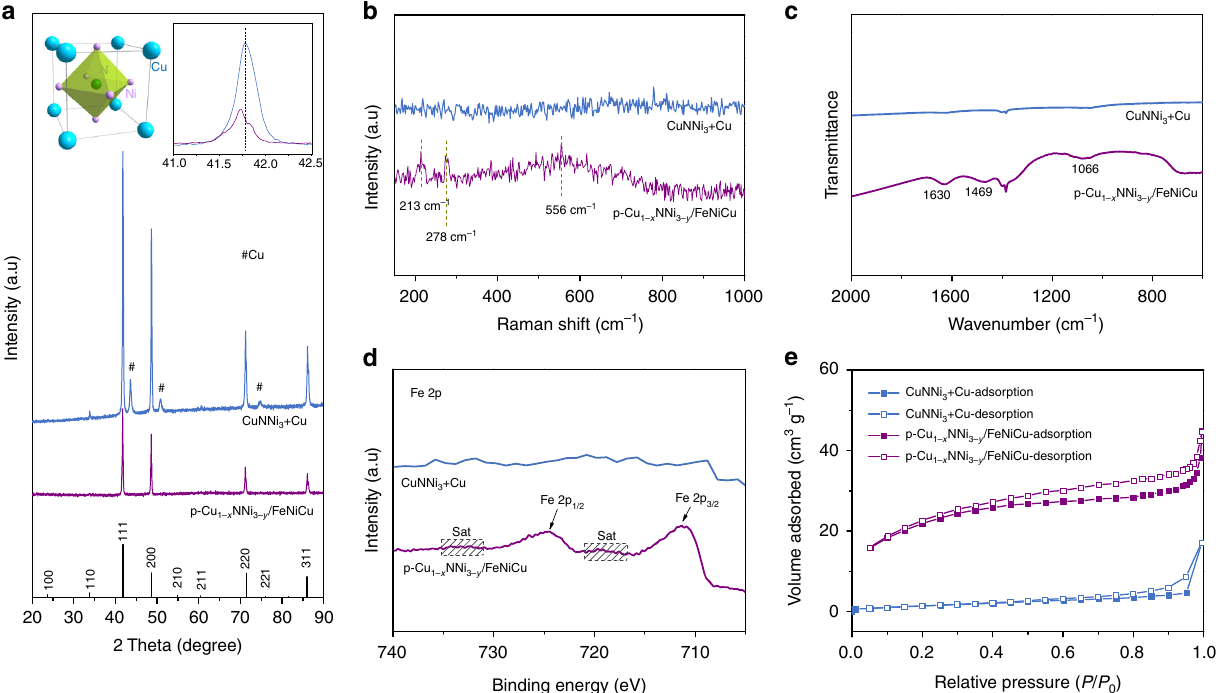
Fig. 2 Characterization of catalysts. a XRD patterns of the CuNNi 3 + Cu and p-Cu 1 − x NNi 3 − y /FeNiCu samples. The insets show the unit cell of antiperovskite CuNNi 3 and the magni fi ed XRD pattern in the 2-theta range of 41 – 42.5°. b Raman spectra, c FTIR, d XPS spectra of Fe 2p, and e N 2 adsorption – desorption isotherms of the CuNNi 3 + Cu and p-Cu 1 − x NNi 3 − y